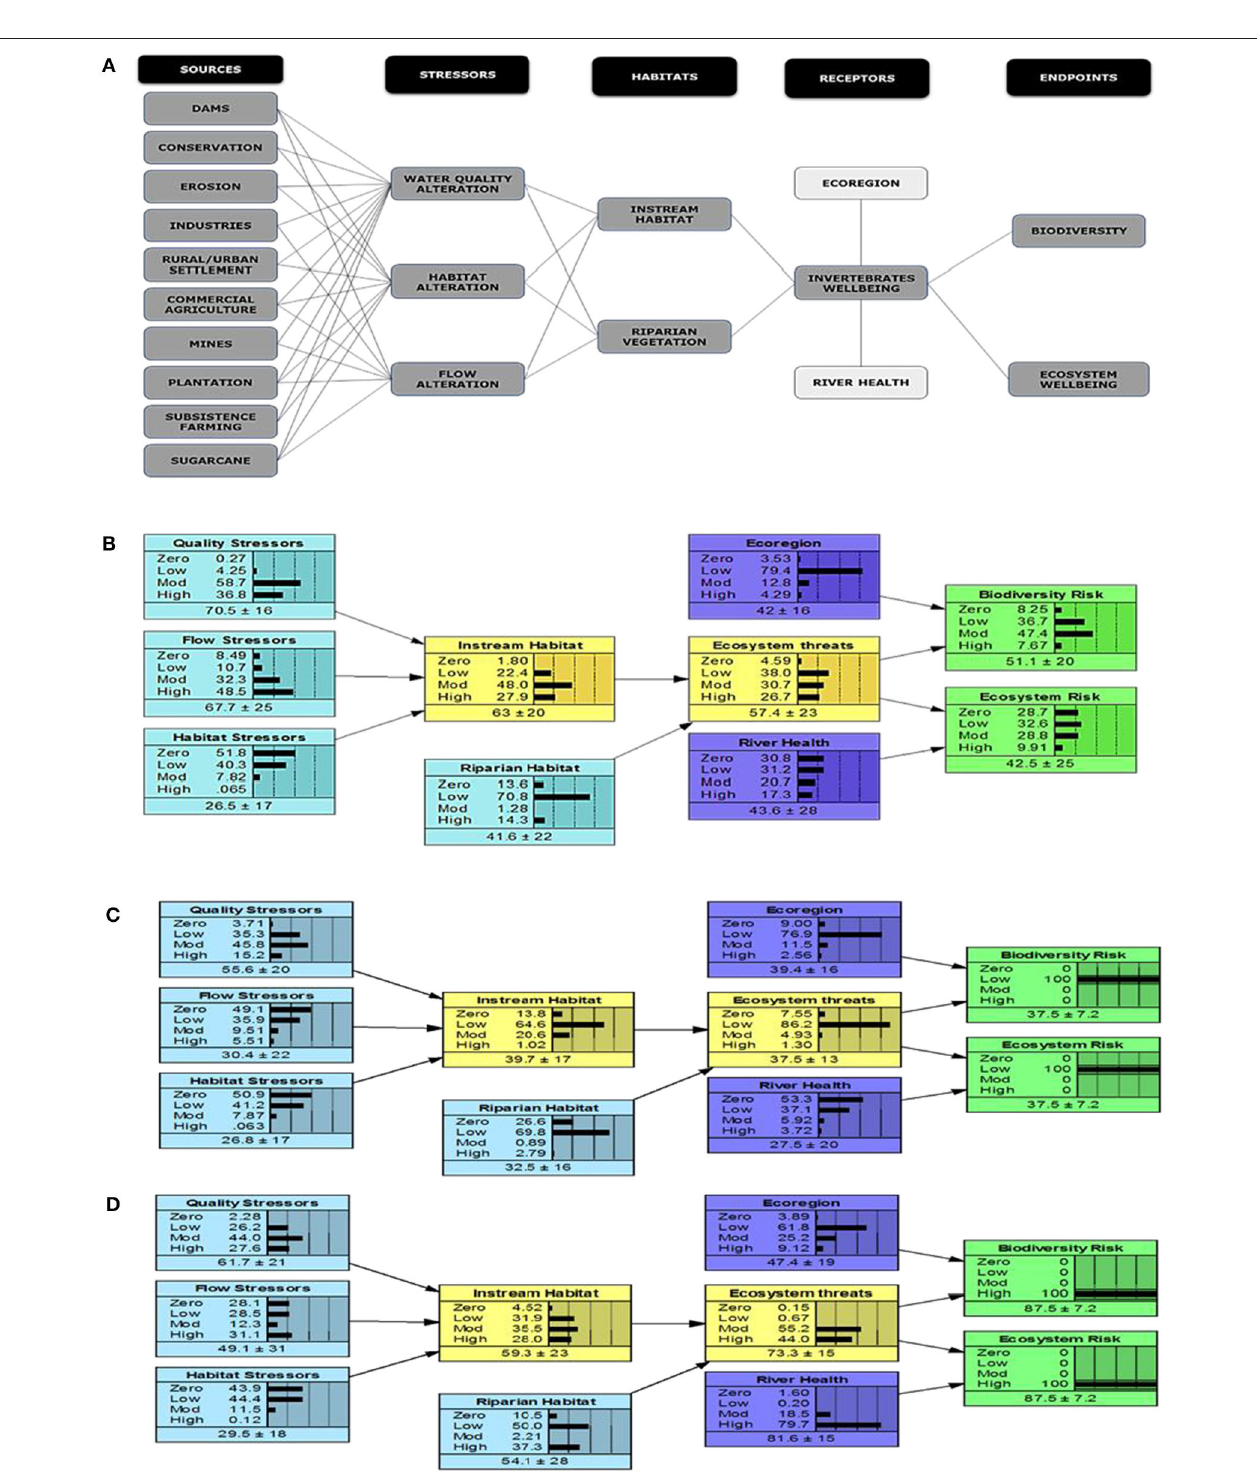
FIGURE 2 | (A) conceptual model showing linkages between sources, stressors, habitats, receptors and assessment endpoints, while (B) Bayesian Network Relative Risk Model, using AMAT1 risk region as an example, (C) 100% low risk to endpoints simulation, and (D) 100% high risk to endpoints simulation. to generate possible outcomes of their impacts on the ecological used as the template for developing the BN-RRM using Netica receptors and the assessment endpoints (Landis and Wiegers, software (Norsys Software Corporation, 2014) ( Figure 2B ). Our RRM was based on a ranking of the stressors and the habitats 2005). Our ranking was based on the relative risk magnitude or